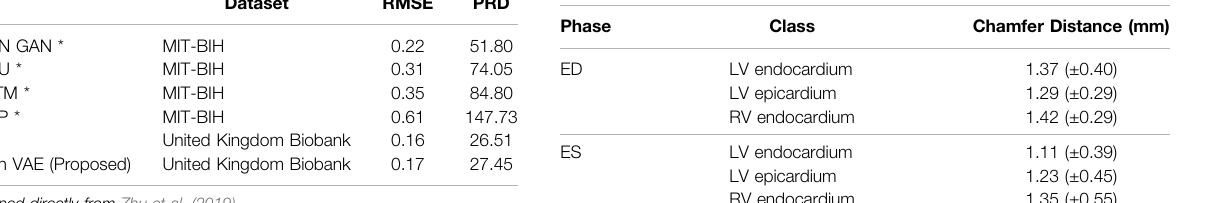
TABLE 2 | ED and ES anatomy reconstruction results of our method on the test dataset.